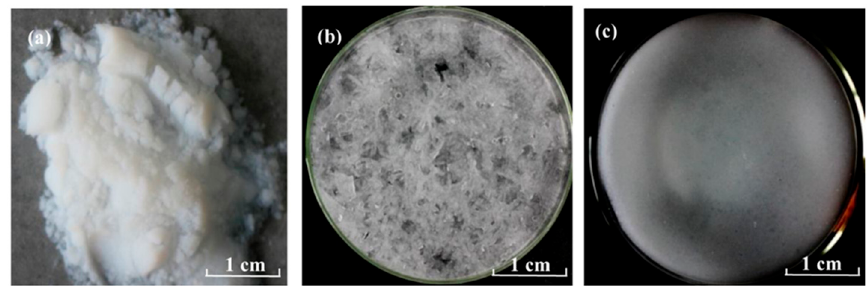
Figure 9. ( a ) Silica (fumed); ( b ) DHPD; and ( c ) DHPD + silica (2 wt.%) [77].